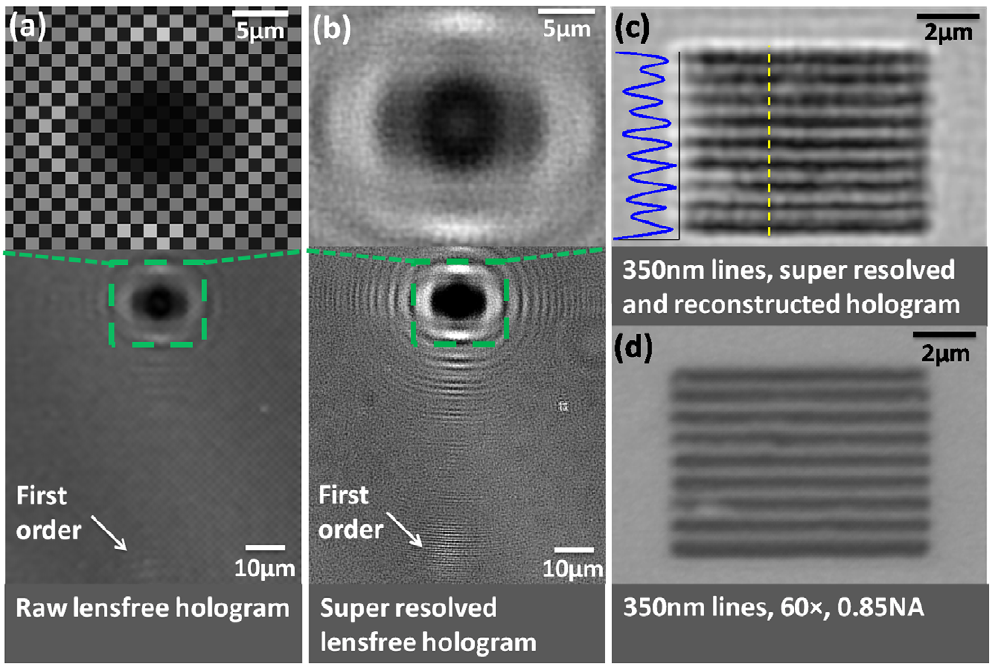
Figure 3. Lensfree imaging results demonstrating 0.35 m m half-pitch lateral resolution. (a) Shows a cropped raw lensfree hologram of a grating structure etched on glass. The fringes on the first diffraction order (indicated by the arrow) cannot be resolved due to under-sampling. (b) Shows a pixel super-resolved (SR) hologram of the same grating. The fringes on the first diffraction order are now resolved. (c) Shows the lensfree image obtained by reconstructing the SR hologram, demonstrating that the grating lines can be clearly resolved. (d) Shows a bright-field microscope image (60 6 , 0.85-NA) of the same grating for visual comparison. Note that the contrast in (a) and (b) was enhanced for illustration of fine holographic